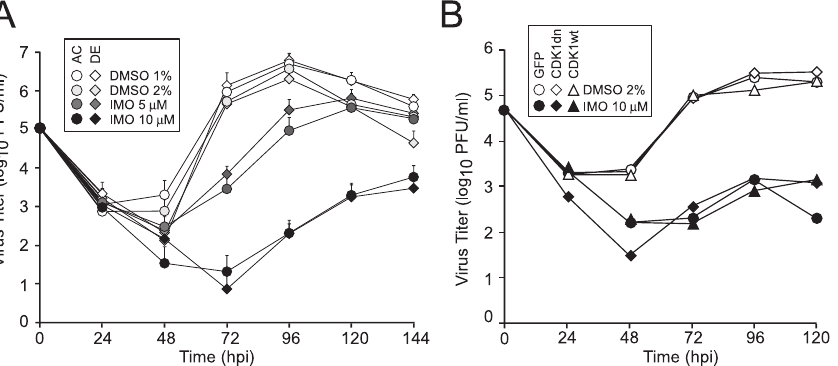
Figure 3. AD169 var ATCC and AD169 var DE Yields Depend on the Activity of Cellular Kinases (A) Mean viral yields with standard deviations (three independent experiments) from HFs infected with AD169 var ATCC or AD169 var DE in the presence of 1% or 2% DMSO or in the presence of 5 l M or 10 l M IMO for 24, 48, 72, 96, 120, and 144 h. (B) Viral yields from GFP-, Cdk1wt-GFP (cid:2) , or Cdk1dn-GFP (cid:2) expressing HFs infected with AD169 var ATCC in the presence of 2% DMSO or 10 l M IMO for 24, 48, 72, 96, and 120 h from one representative